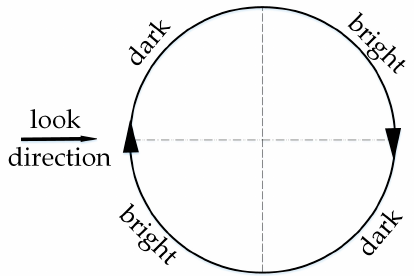
Figure 1. Schematic diagram of imaging geometry for idealized anticyclonic eddy [11].